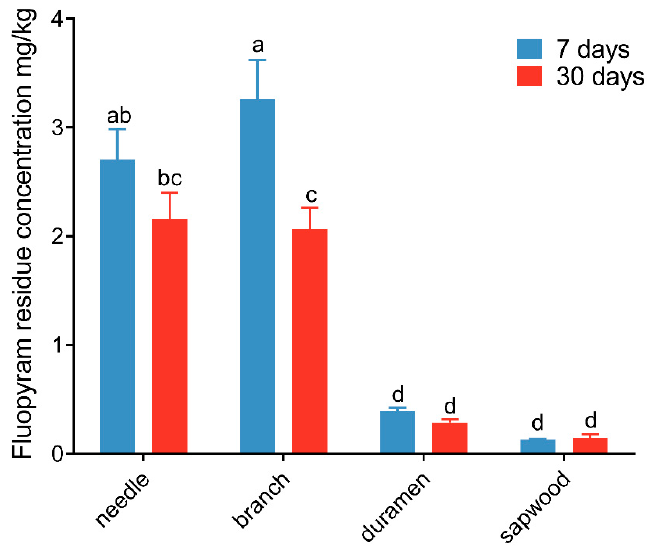
Figure 5. Residual concentration of fluopyram in different samples of Pinus massoniana at 7 days and 30 days post-application of the fluopyram suspension concentrate. Bars with different letters indicate statistical significance at p < 0.05.